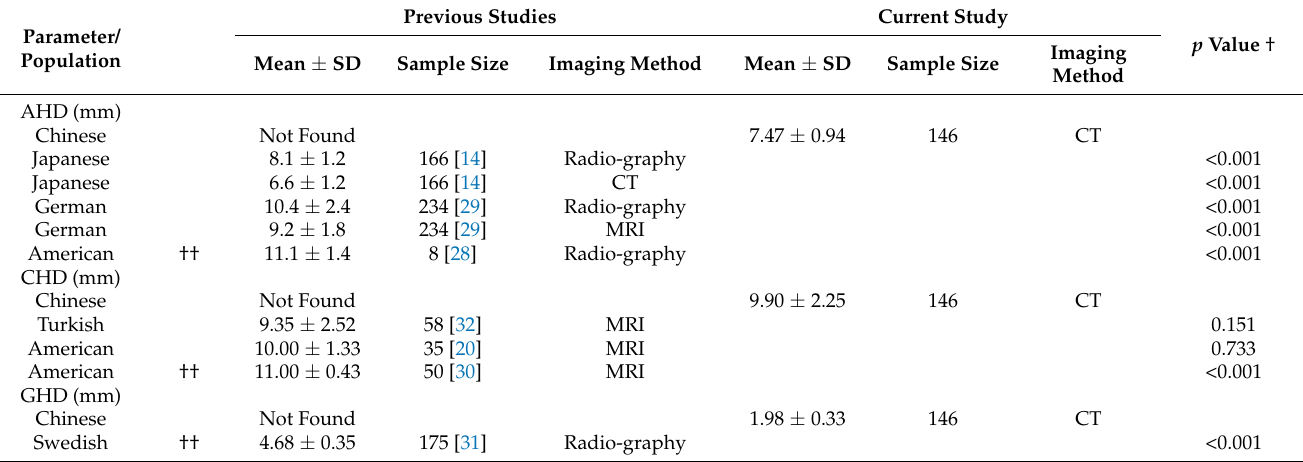
Table 4. Comparison of current reported AHD, CHD, and GHD with previous